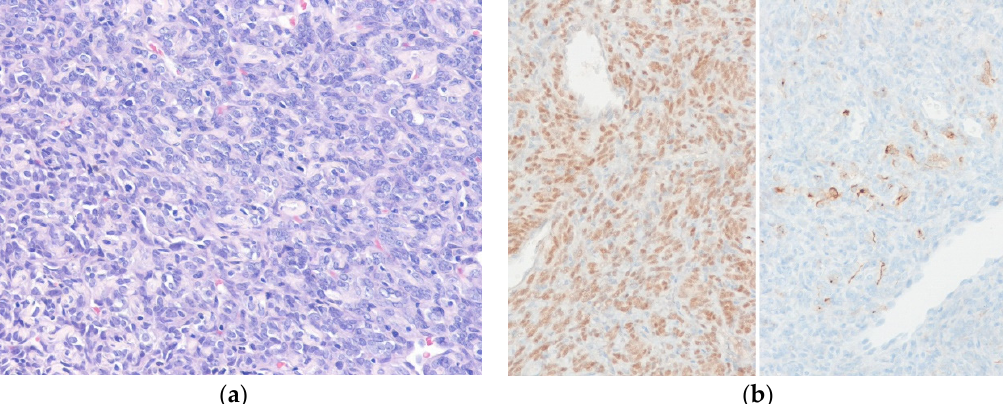
Figure 10. Poorly differentiated synovial sarcoma. ( a ) The tumor shows hypercellular rounded tumor cells. Slightly spindled tumor cells are also present. Mitotic figures are frequently seen. ( b ) The tumor cells are strongly and diffusely positive for TLE1 (left) and focally positive for cytokeratin (AE1/AE3) (right) (H&E stain, original magnification 200× a ; TLE1 and cytokeratin (AE1/AE3) immunostain, original magnification 200× b ).